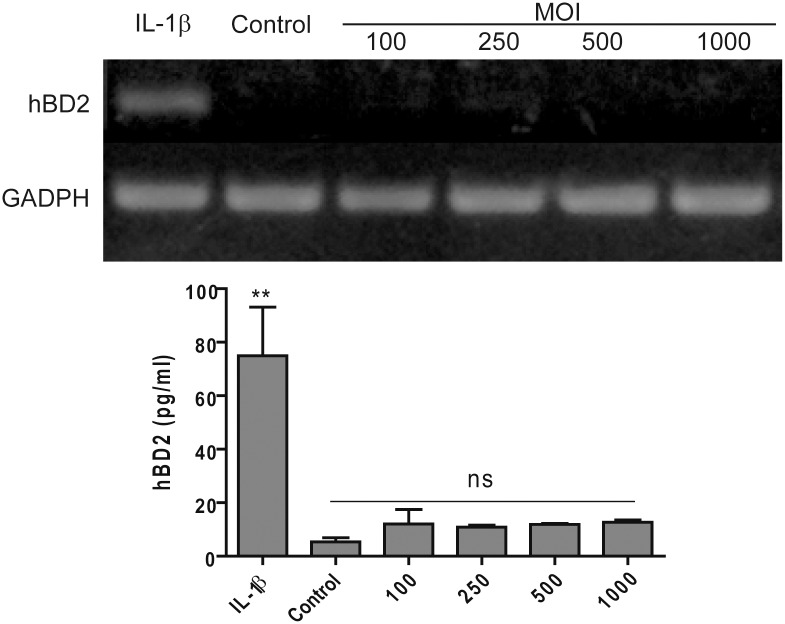
Human alveolar epithelial cells do not produce hBD2 in response to B. abortus infection.A549 cells were infected with B. abortus at different multiplicities of infection (MOI). At 48 h p.i. transcription levels of mRNA for hBD2 were determined by semiquantitative RT-PCR (upper panel), and culture supernatants were harvested for hBD2 determination by commercial ELISA (lower panel). As a positive control of hBD2 induction, cells were stimulated in parallel with recombinant IL-1β. ELISA results are the mean ± SEM of three independent experiments. **, p<0.01 and ns, non-significant difference versus untreated (control) cells (ANOVA followed by Dunnett’s test).